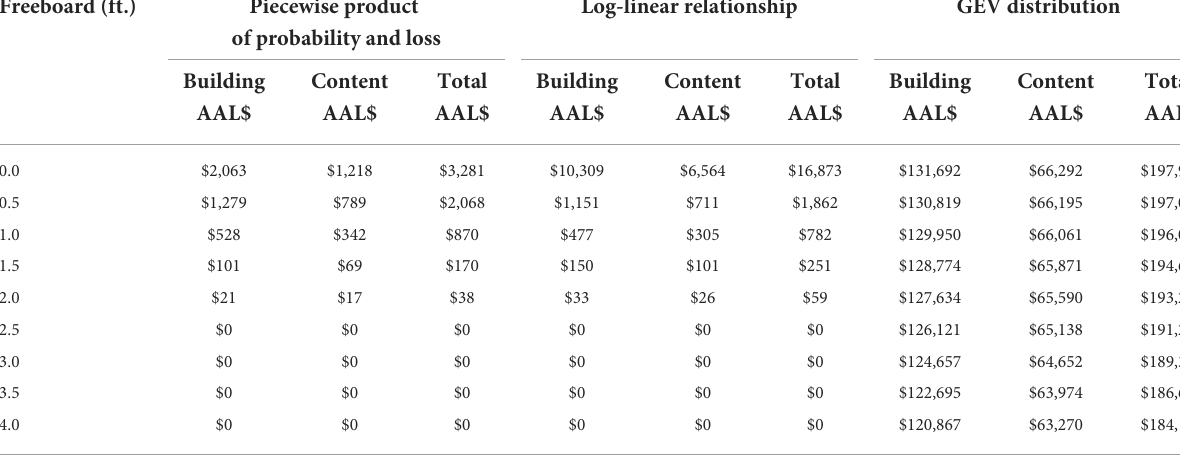
TABLE 3 Comparison of calculated building and content annual average loss by calculation method and freeboard amount for the Metairie, Louisiana, case study. Freeboard